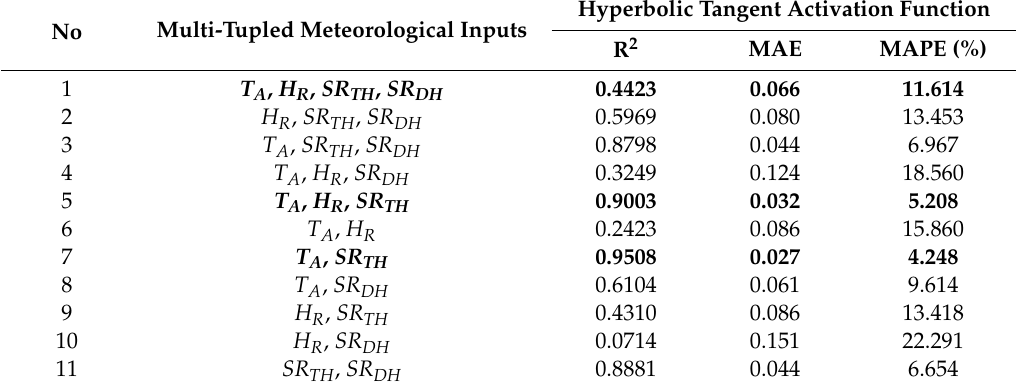
Table 2. Daily photovoltaic power prediction results of the GWO-MLP method, which used the hyperbolic tangent activation